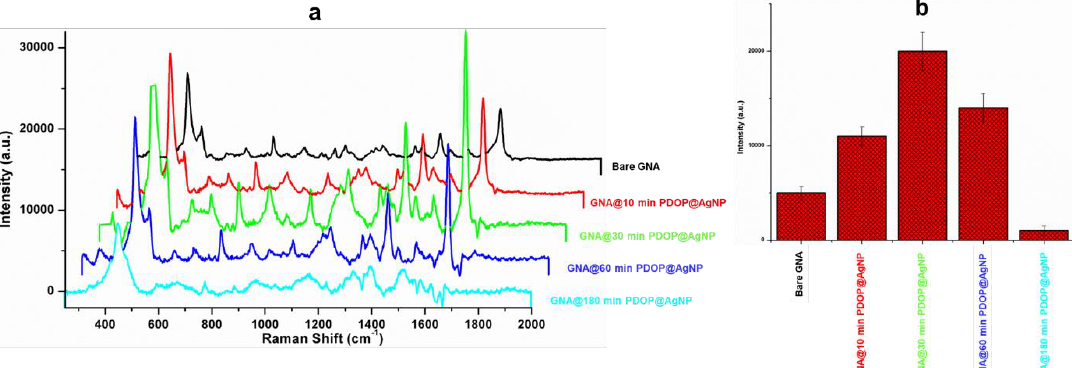
Figure 5. SERS activity tests of GNA@PDOP@AgNP platforms for different PDOP deposition times. ( a ) Representative SERS spectra for each platform; ( b ) the intensity histogram of different platforms for prominent peak of MB at 1620 cm −1 .